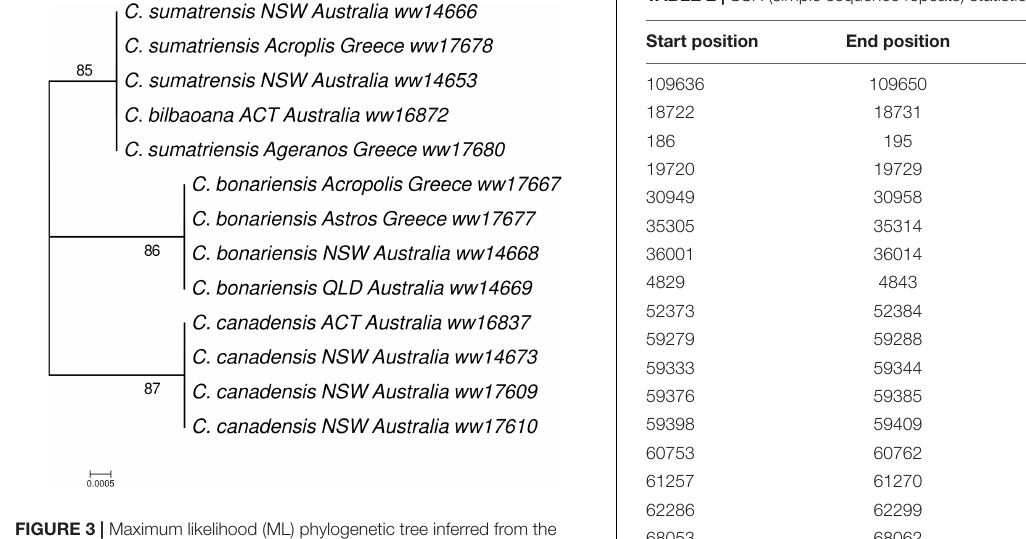
FIGURE 3 | Maximum likelihood (ML) phylogenetic tree inferred from the rps16 – trnQ-UUG intergenic spacer across 13 samples of Conyza species.